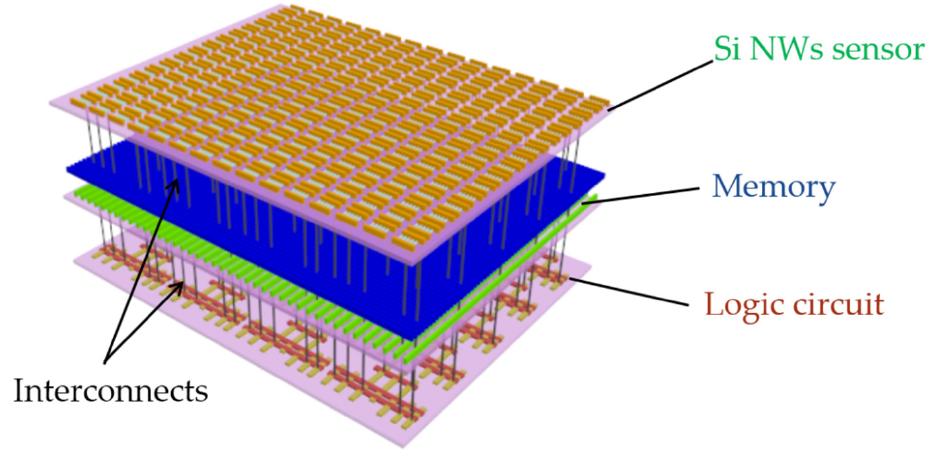
Figure 1. Illustration of monolithic three-dimensional integrated circuits (3D-ICs): bottom logic circuits; middle memory and top silicon nanowire (Si NW) sensors.